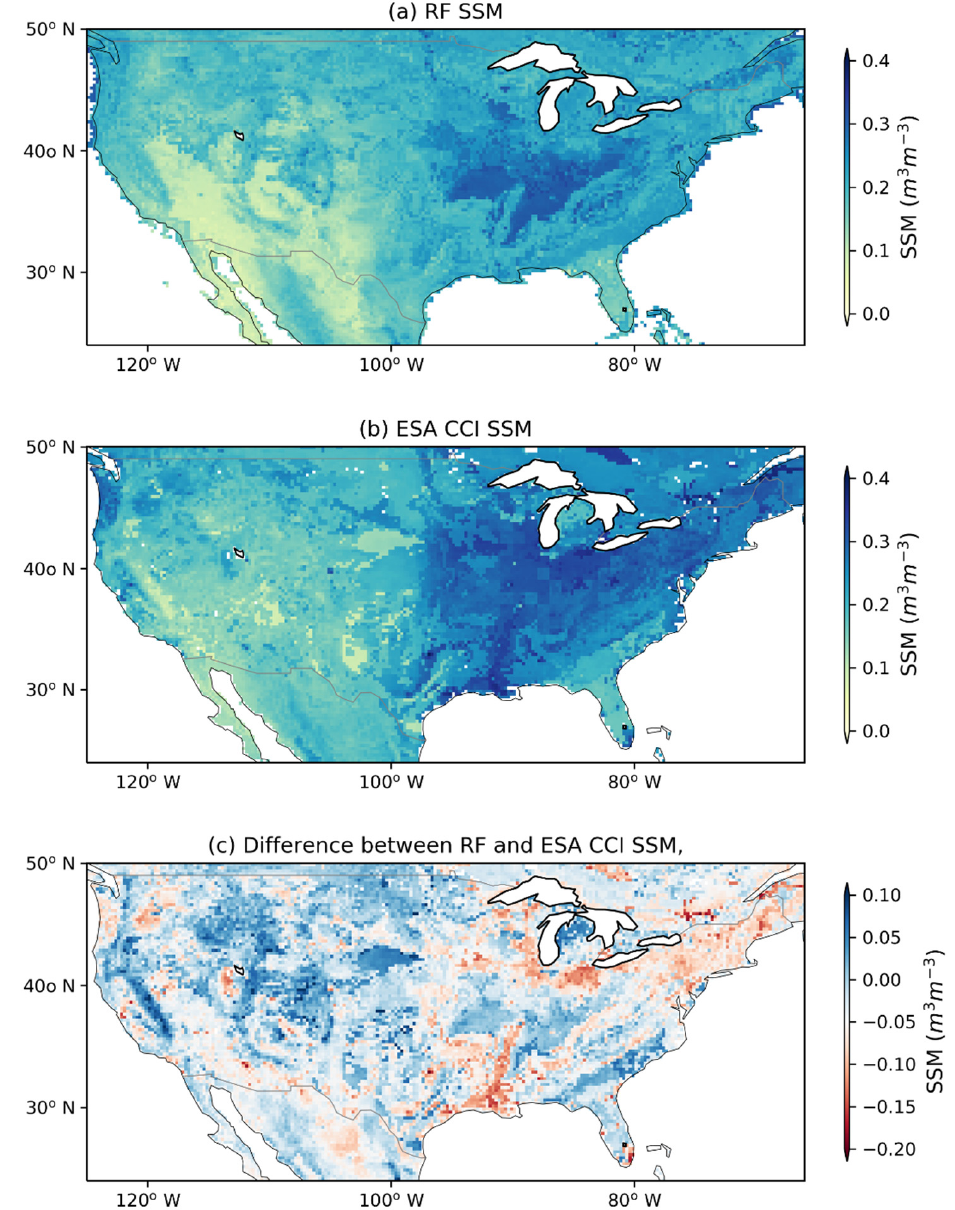
Figure 7. Long-term mean SSM map over the Continental United States with 0.25 degrees resolution: ( a ) RF model predicted SSM; ( b ) ESA-CCI SSM, ( c ) Difference between RF model and ESA-CCI SSM over 2000 to 2018.